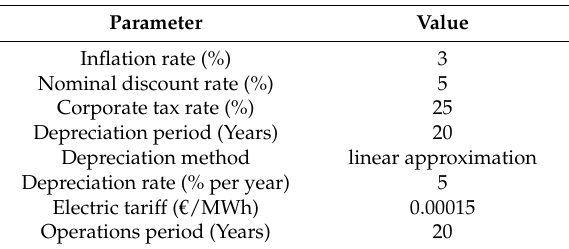
Table 8. Financial